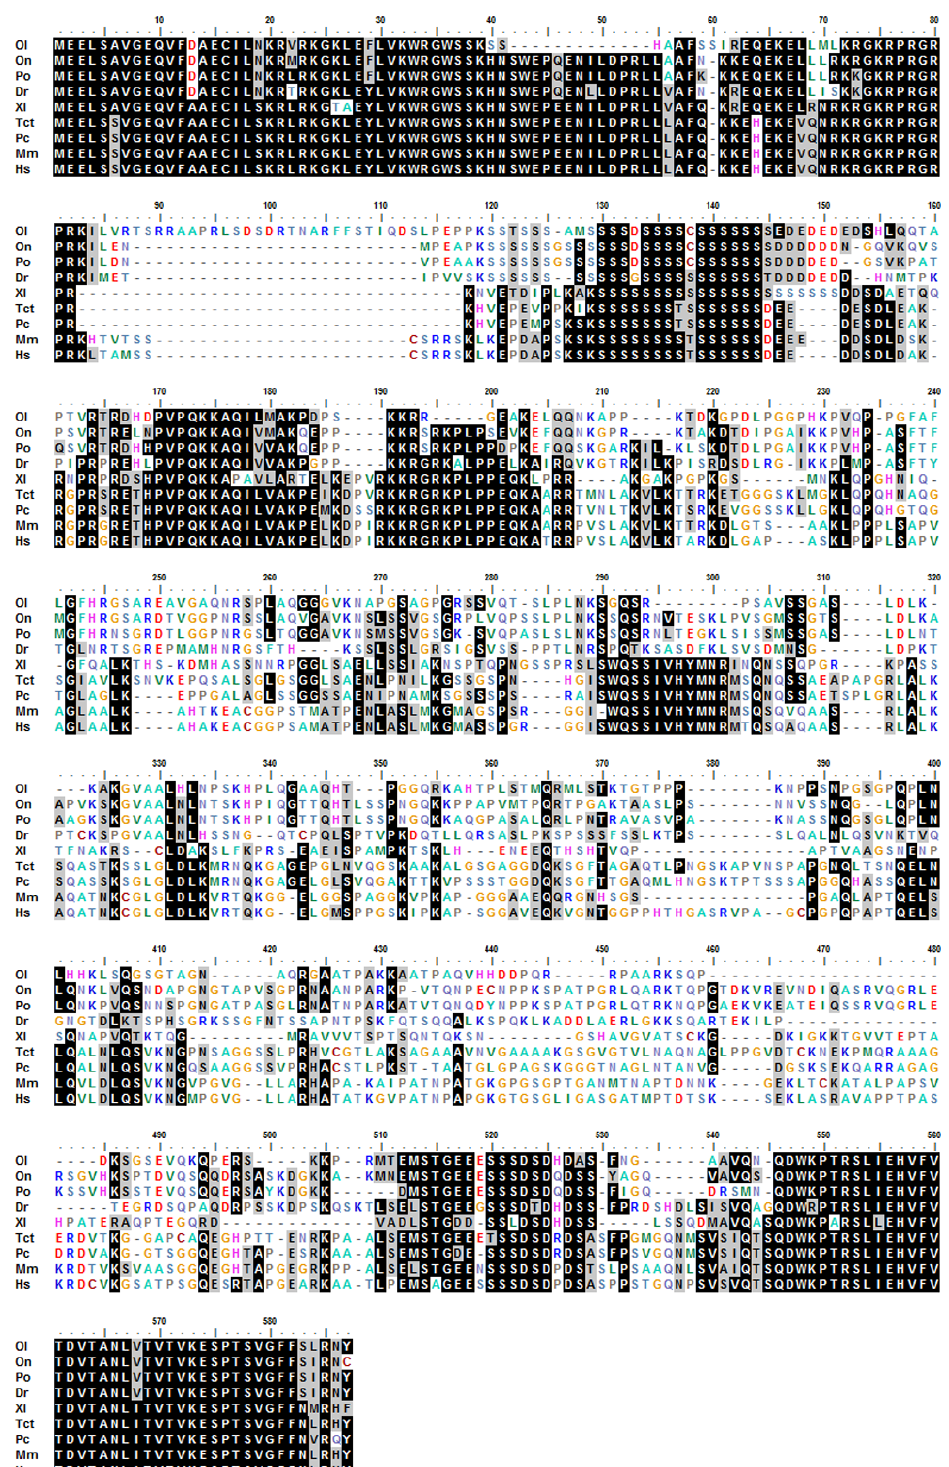
Figure 2. Sequence alignment of the CBX2 protein between different species. Abbreviations: Ol, Oryzias latipes ; On, Oreochromis niloticus ; Po, Paralichthys olivaceus ; Dr, Danio rerio ; Xl, Xenopus laevis ; Tct, Terrapene carolina triunguis ; Pc, Phasianus colchicus ; Mm, Mus musculus ; Hs, Homo sapiens .